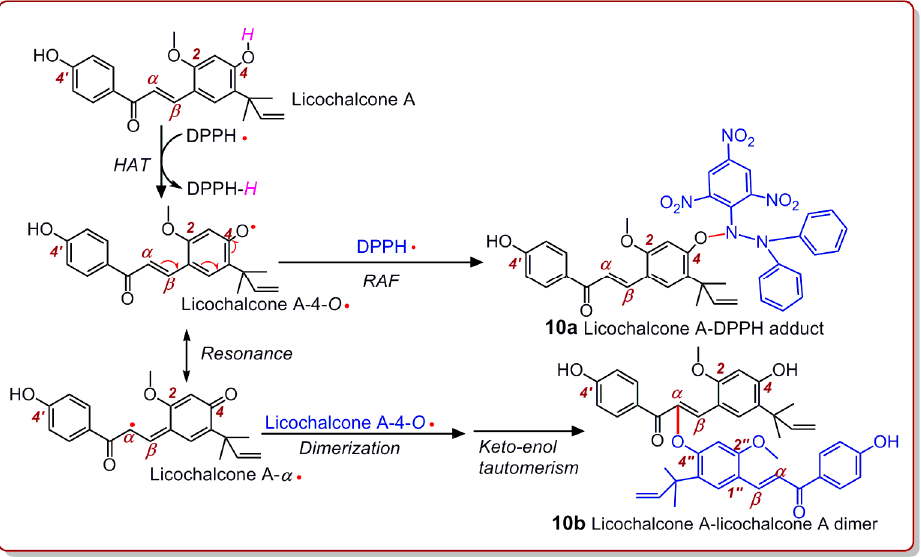
Figure 10. Proposed RAF reactions of licochalcone A when mixed with the DPPH• radical.